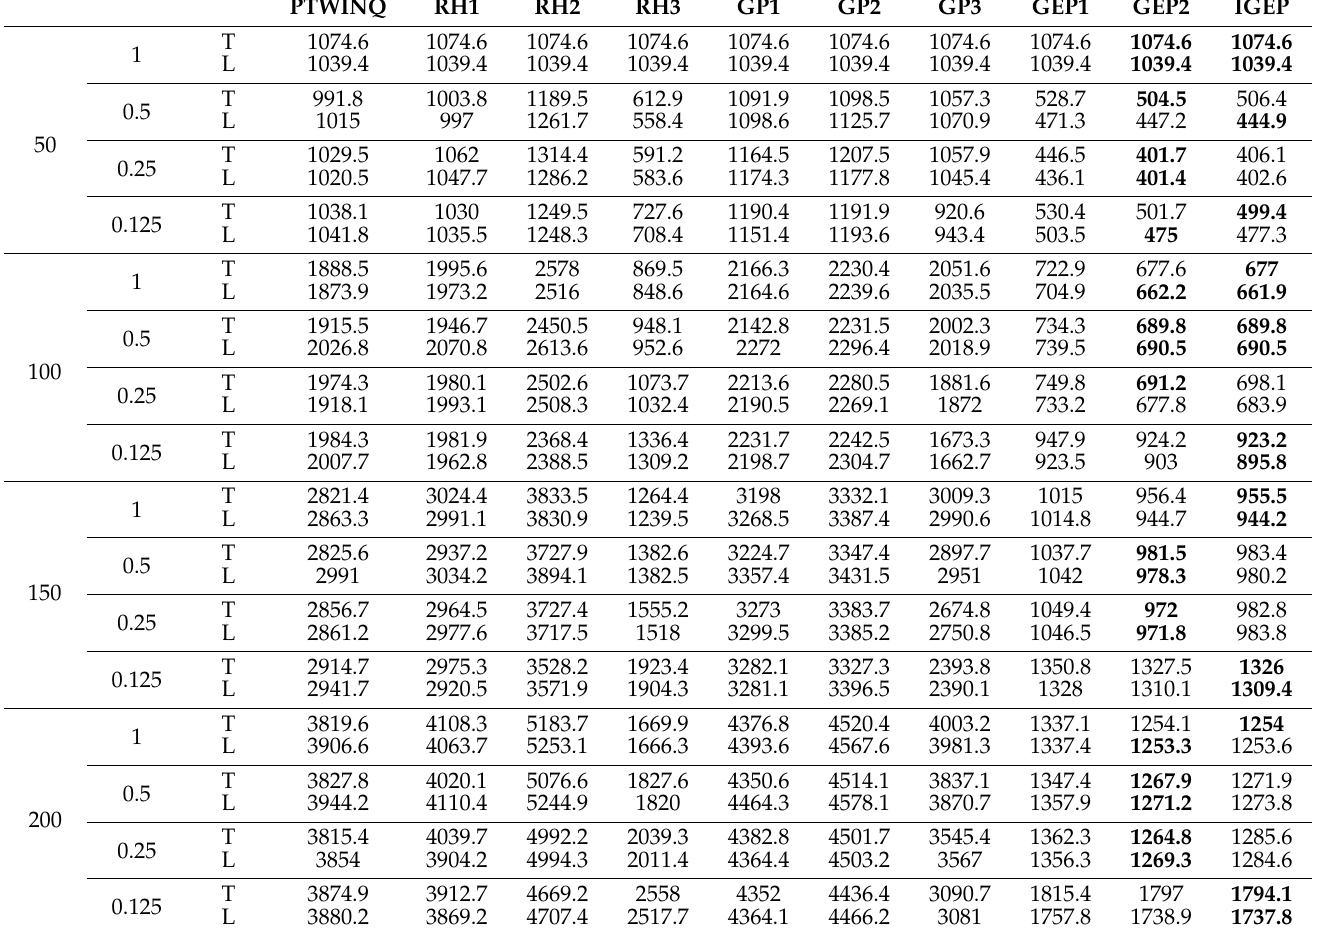
Table 1. Comparison of discovered/combination rules with minimum